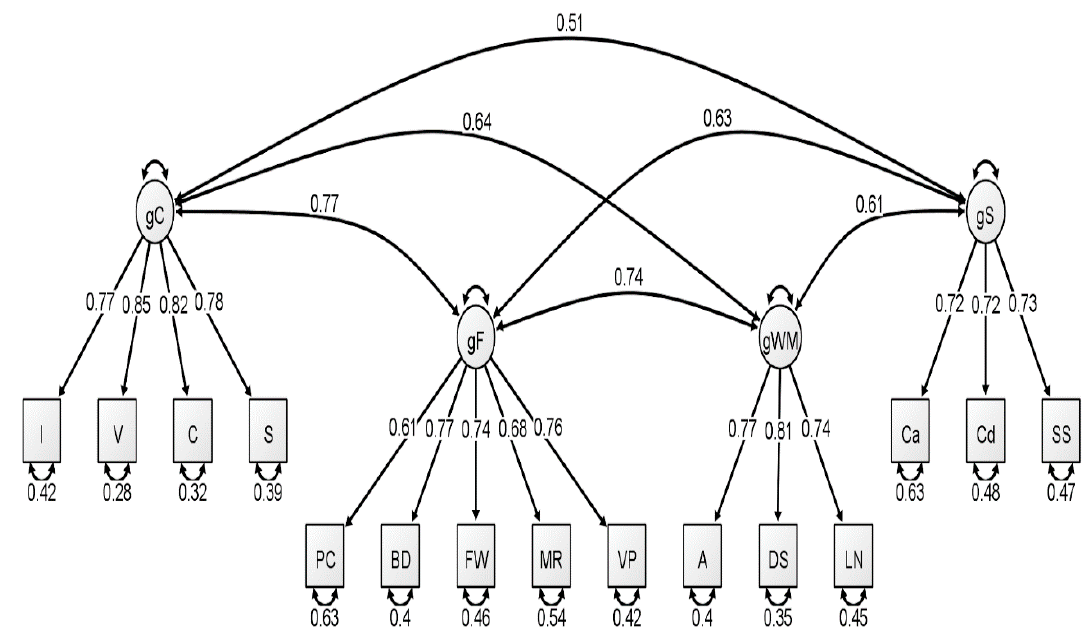
Figure 1. Correlated four-factor measurement model of the young group WAIS-IV correlation matrix. All values are standardized from the confirmatory factor analysis conducted using lavaan. Figure generated using Ω nyx. gC = crystallized intelligence; gF = fluid reasoning; gWM = working memory; gS = processing speed; BD = block design; S = similarities; DS = digit span; MR = matrix reasoning; V = vocabulary; A = arithmetic; SS = symbol search; VP = visual puzzles; I = information; Cd = coding; LN = letter–number sequencing; FW = figure weights; C = comparisons; Ca =